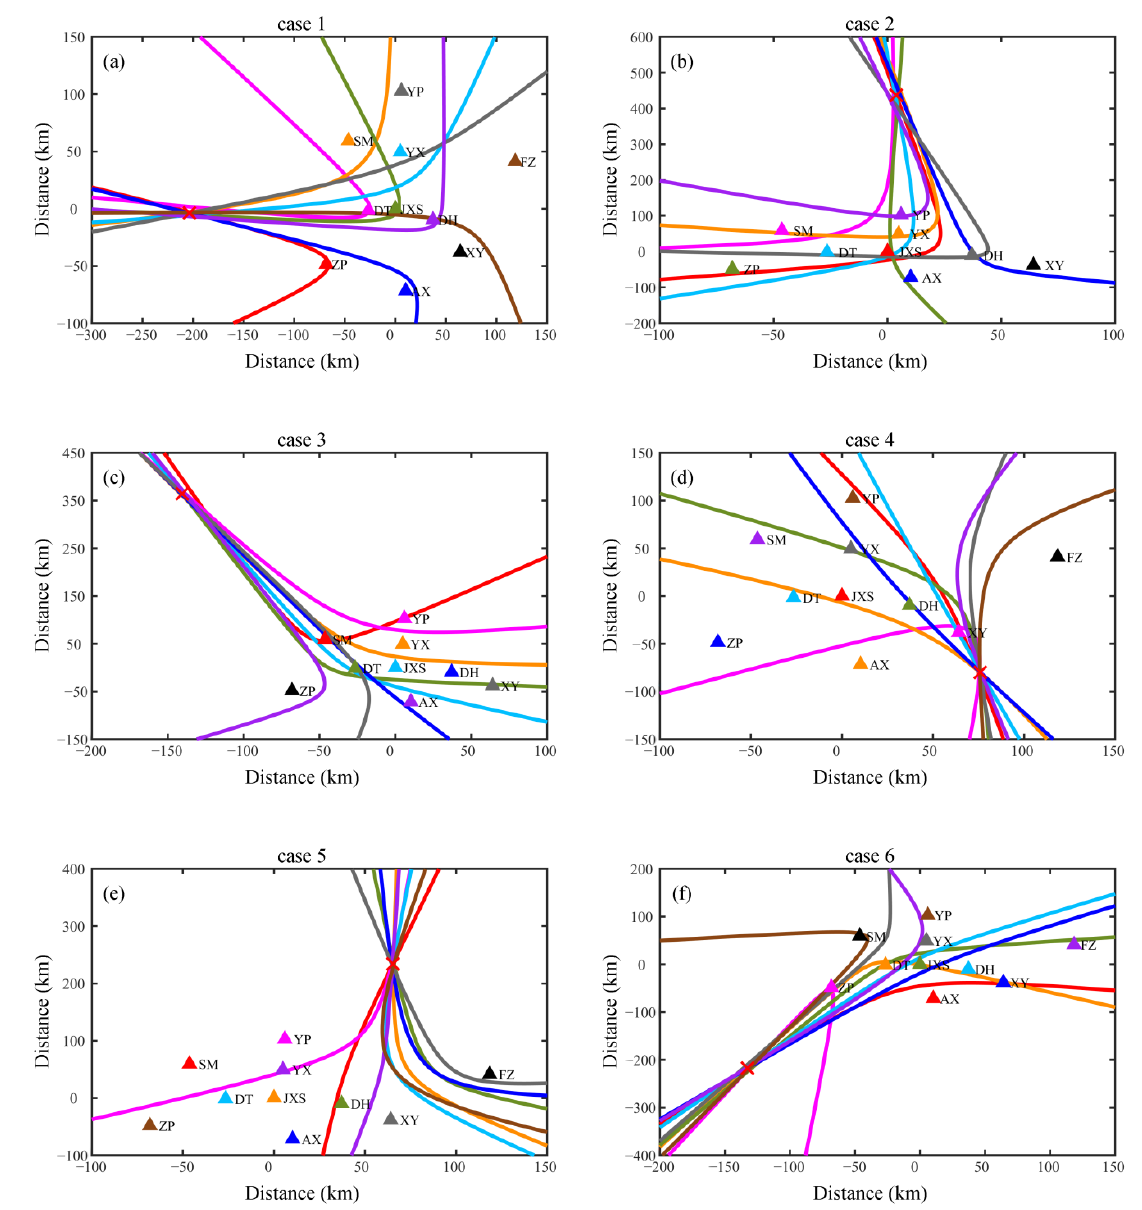
Figure 4. The reference location of six cases estimated by the ToA technique with arrival time differences using the time corresponding to the peak field. ( a – f ) correspond to the results of case 1 to case 6. The hyperbolas of different colors correspond to the arrival time differences between the center station (black triangle) and the station of same color as the hyperbola. The red crosses mark the reference